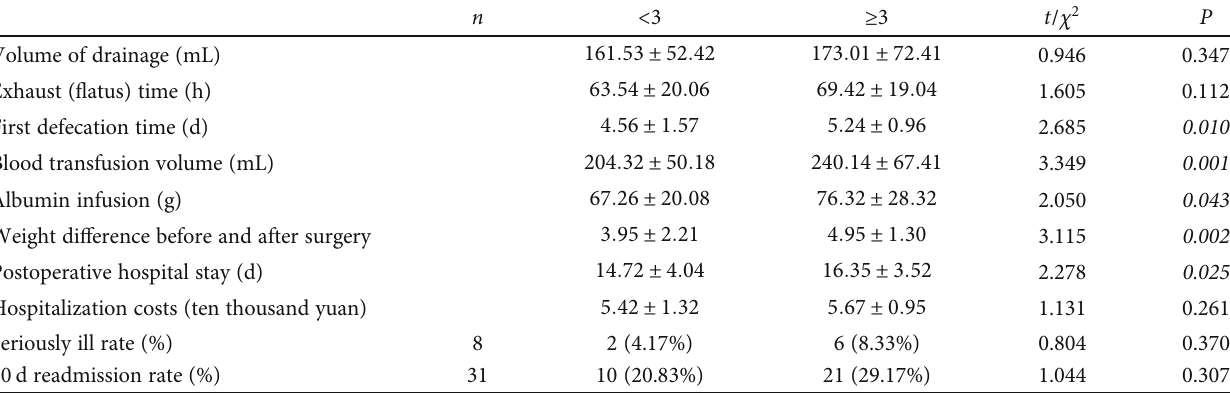
Table 3: Comparison of short- and long-term postoperative recovery between the two groups.